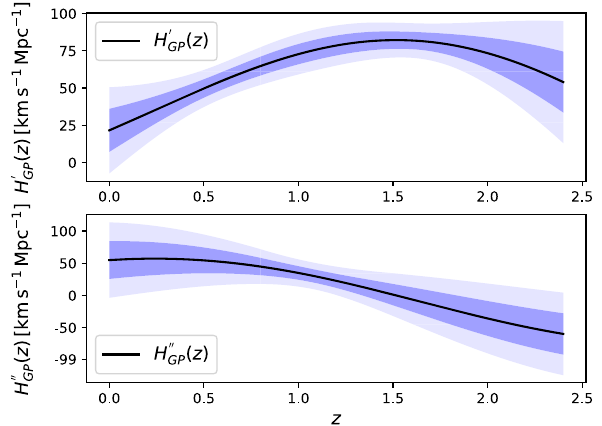
Fig. 2 Upper panel: Reconstruction of H (cid:5) GP ( z ) via GP from OHD (Table 1). Lower panel: Reconstruction of H (cid:5)(cid:5) GP ( z ) via GP from OHD (Table1).Thebluebandsshowthe1 σ and2 σ